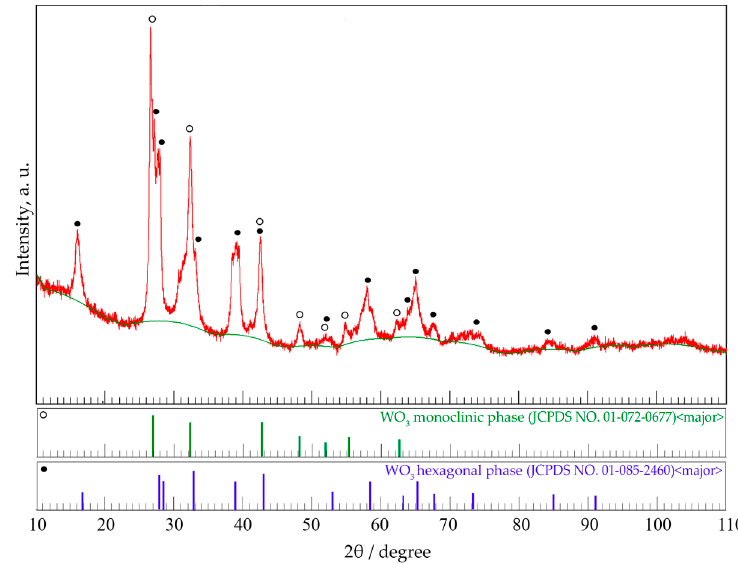
Figure 9. XRD pattern of WO 3 powder prepared by USP method.